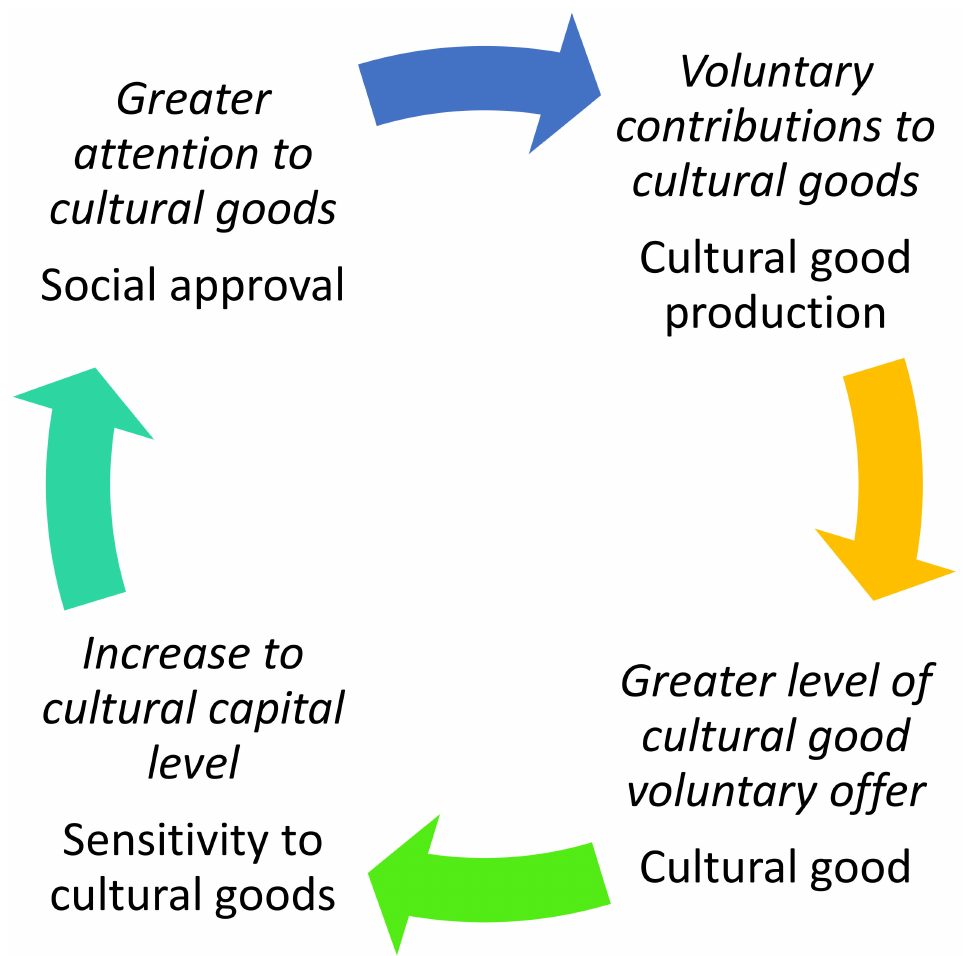
Figure 1. Cultural goods and cultural capital virtuous